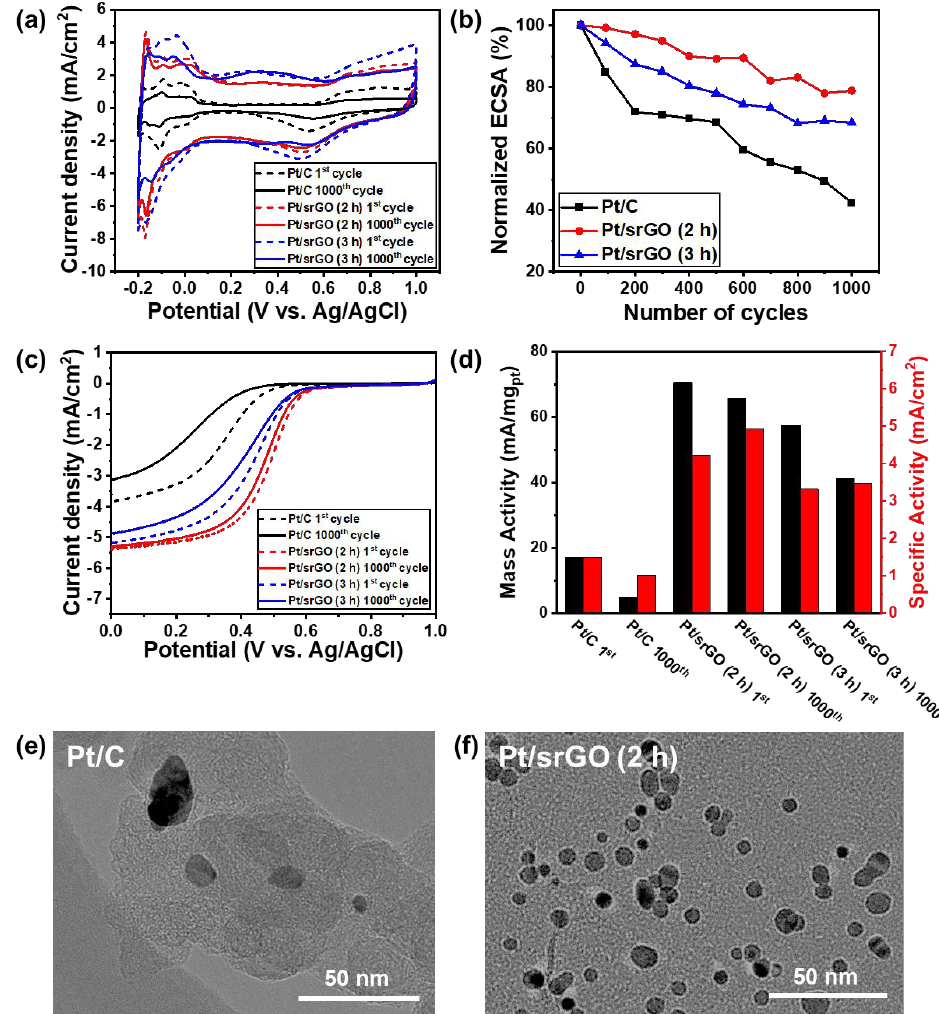
Figure 6. ( a ) CV curves of Pt/srGO (2 h), Pt/srGO (3 h), and Pt/C before and after the ADTs for 1000 cycles in N 2 -saturated 0.5 M H 2 SO 4 at a scan rate of 50 mV/s. ( b ) ECSAs of the samples over 1000 electrochemical cycles. ( c ) Polarization CV curves of samples before and after ADTs for 1000 cycles in O 2 -saturated 0.5 M H 2 SO 4 at a scan rate of 5 mV/s and GCE rotational speed of 1600 rpm. ( d ) Mass and specific activities of samples at 0.4 V vs. Ag/AgCl. TEM images of ( e ) Pt/C and ( f ) Pt/srGO (2 h) after ADTs for 1000 cycles.